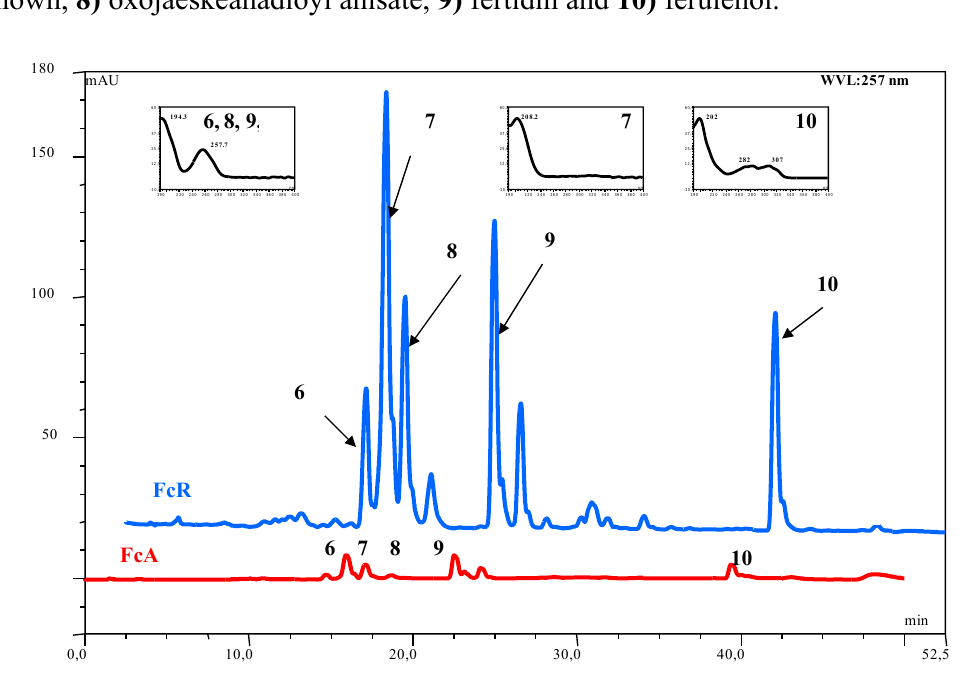
Figure 3. Spectra at 257 of FcA and FcR with UV spectra of 6) acetoxyferutinin, 7) unknown, 8) oxojaeskeanadioyl anisate, 9) fertidin and 10)